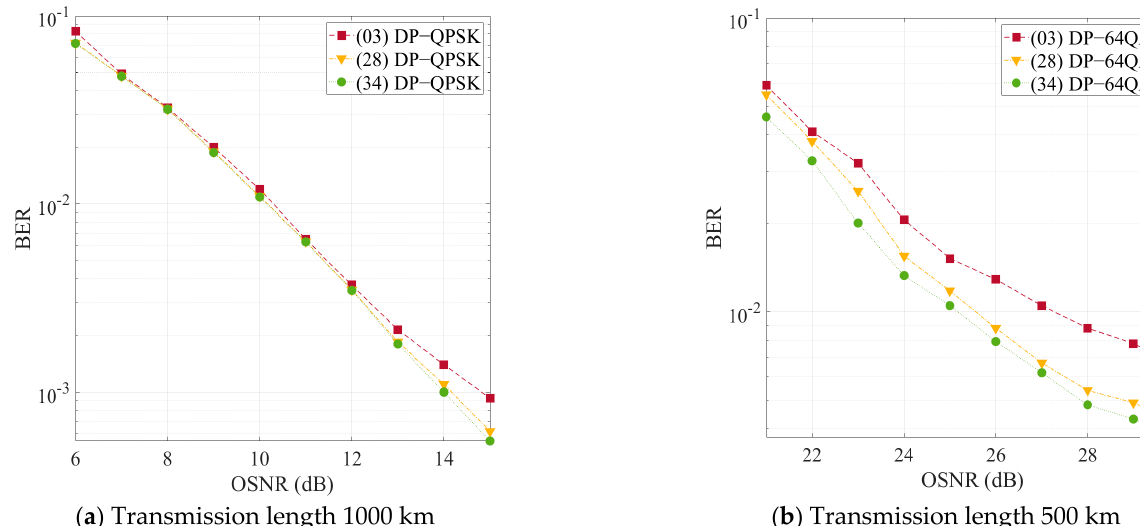
Figure 7. The BER performance of the DP-QPSK and DP-64 QAM data. We compare the equalization performance of the filters of FD-CDE-FIR, SVDLS-FIR, and AMPSO-FIR under different OSNR. ( a ) The transmission distance of DP-QPSK modulation is 1000 km; ( b ) The transmission distance of DP-64 QAM modulation is 500 km.